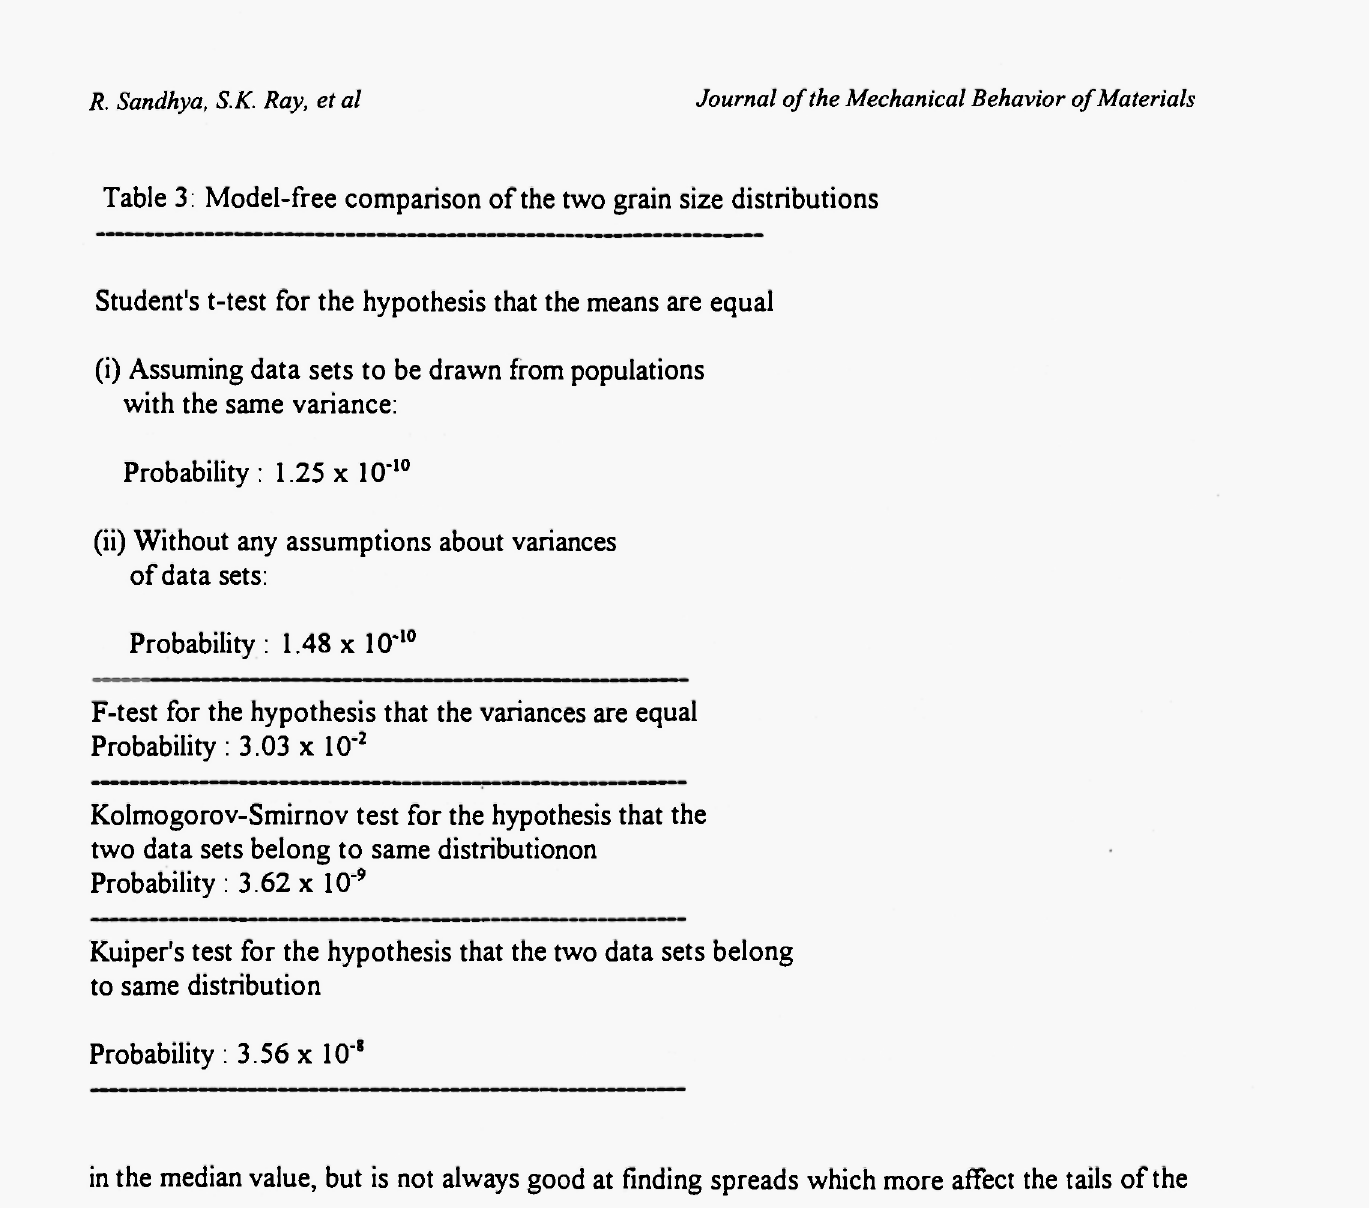
Table 3: Model-free comparison of the two grain size distributions